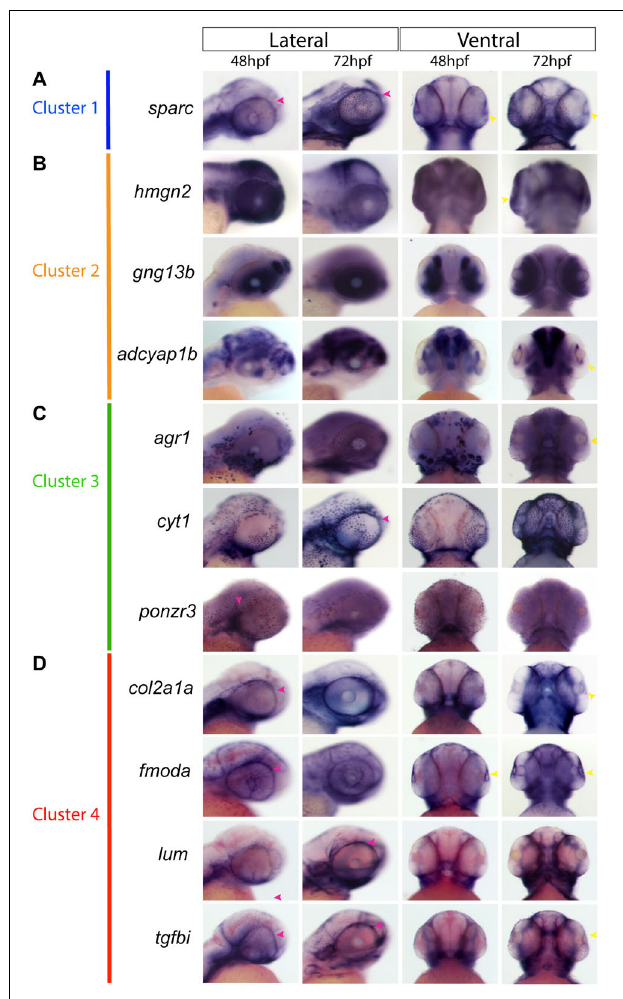
FIGURE 6 | Gene expression of sequencing-derived genes. Whole-mount in situ hybridization for novel ASM marker gene mRNA expression patterns was performed during early (48 hpf) and intermediate stages (72 hpf) of AS development and observed in lateral and ventral views. (A) , Sparc expression representing cluster 1. (B) gng13b , hmgn2 , and adcyap1b expression representing cluster 2. (C) cyt1 , agr1 , and ponzr3 expression representing cluster 3. (D) lum , fmoda , col2a1a , and tgfbi expression representing cluster 4. Yellow arrowheads indicate AS expression, magenta arrowheads indicate periocular